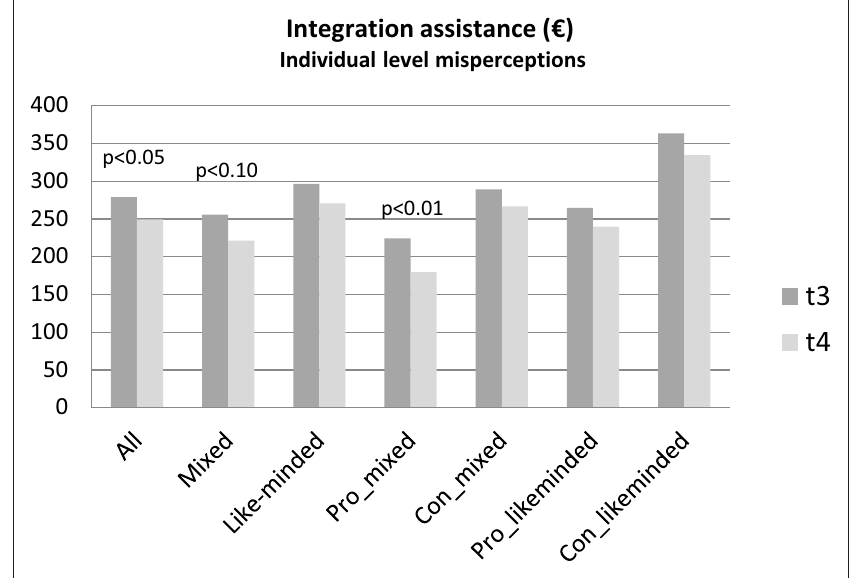
Figure 4: Misperceptions measured before (t3) and after (t4) deliberation across treatments and enclaves; p-values indicate significant change in level of